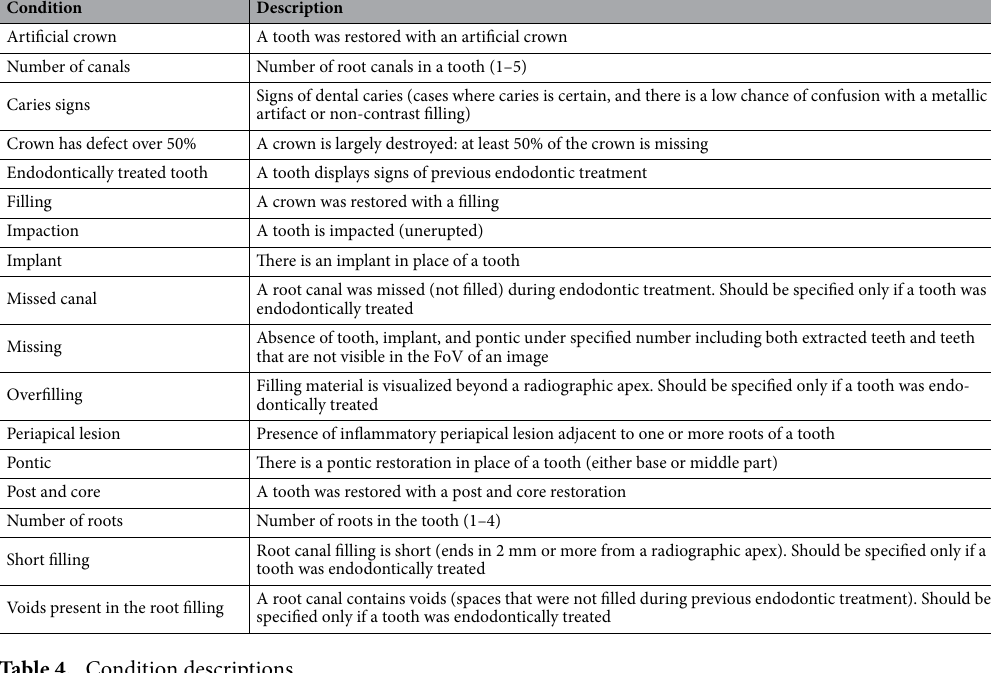
Table 4. Condition